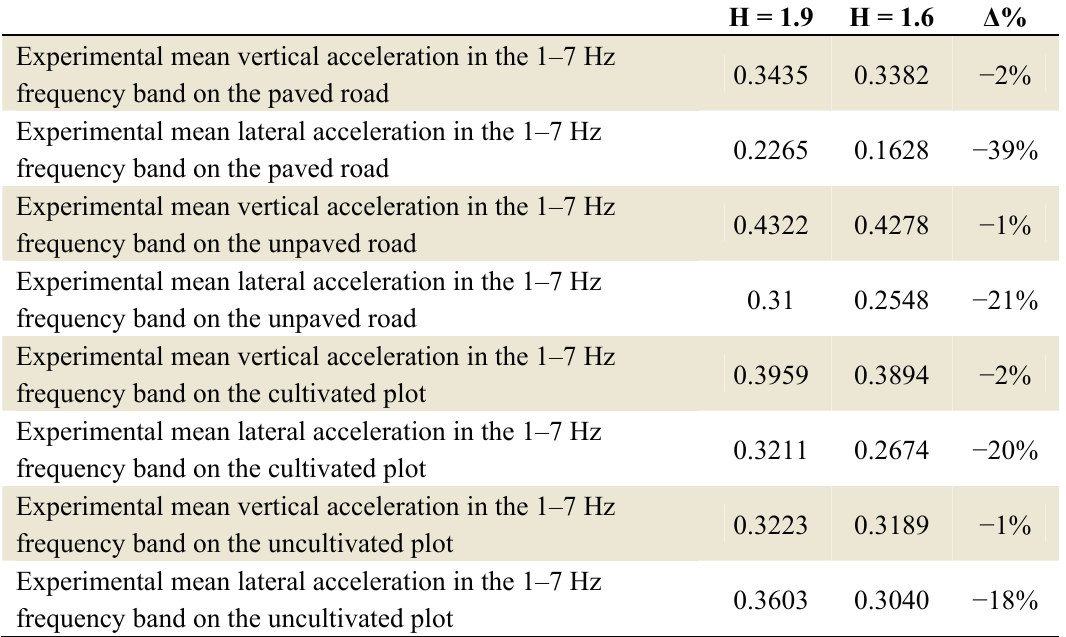
Table 3. Evolution of the experimental vertical and lateral mean accelerations in the 1–7 Hz frequency band for the four surfaces in the test, when the measurement point is reduced by 15%, from 1.9 to 1.6